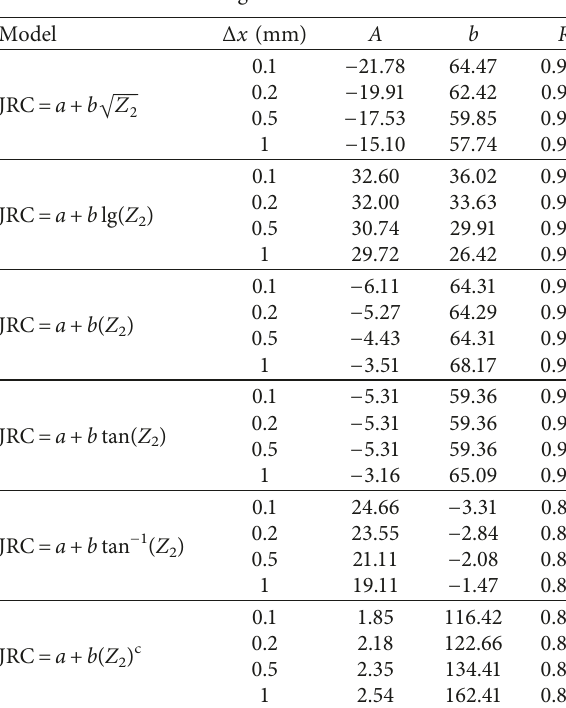
Table 2: Fitting results of the six